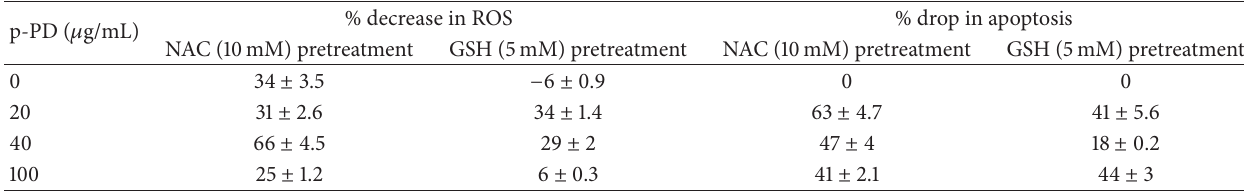
Table 5: Effect of NAC and GSH pretreatment on ROS generation and apoptosis in A375 cells. p-PD ( 𝜇 g/mL)